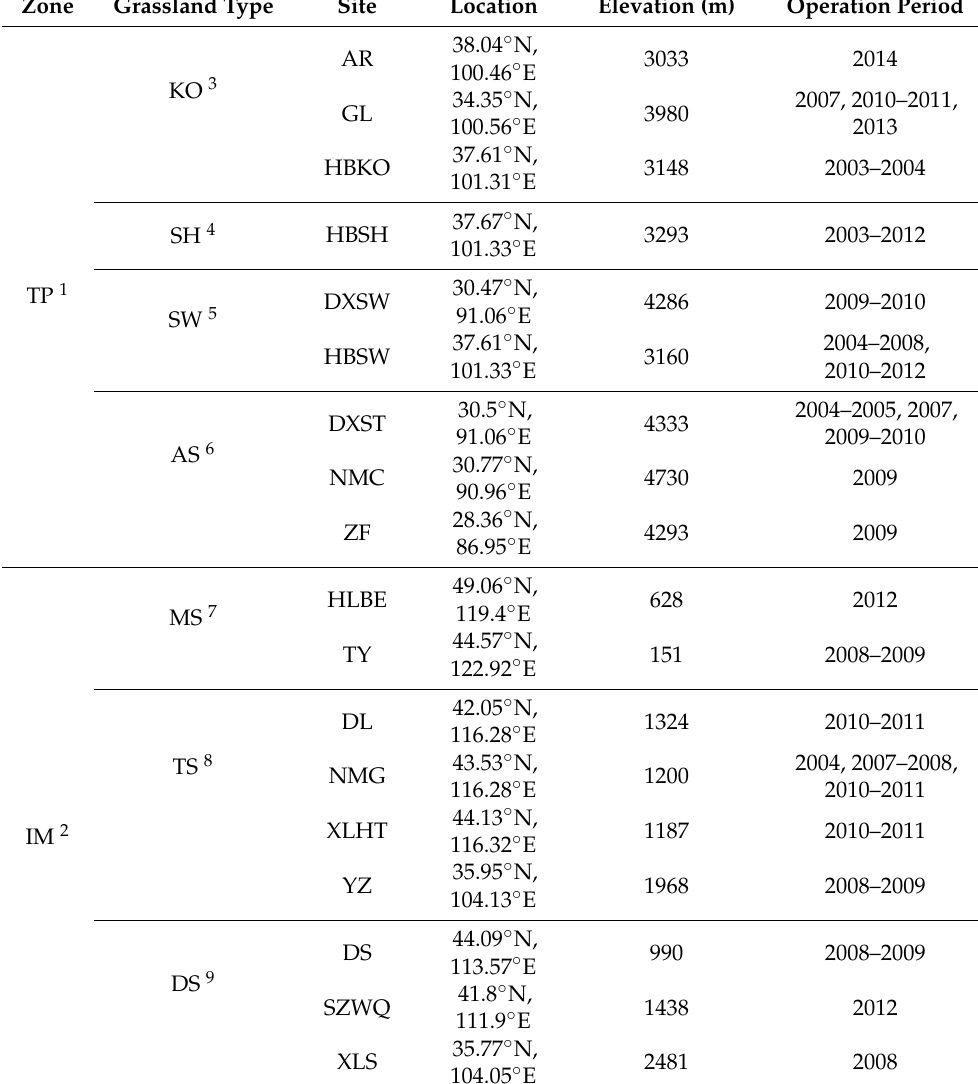
Table 1. Main characteristics of the 18 flux sites in northern China’s grasslands